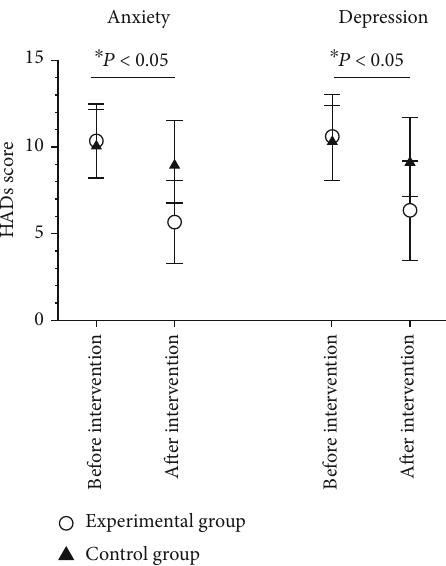
Figure 1: Hospital Anxiety and Depression Scales (HADS) were used to compare the statistical di ff erences between the anxiety signi fi cance scores of the experimental group and the control group after intervention, so as to evaluate the level of depression and anxiety of patients. Note: compared with the experimental group, ∗ P < 0 : 05